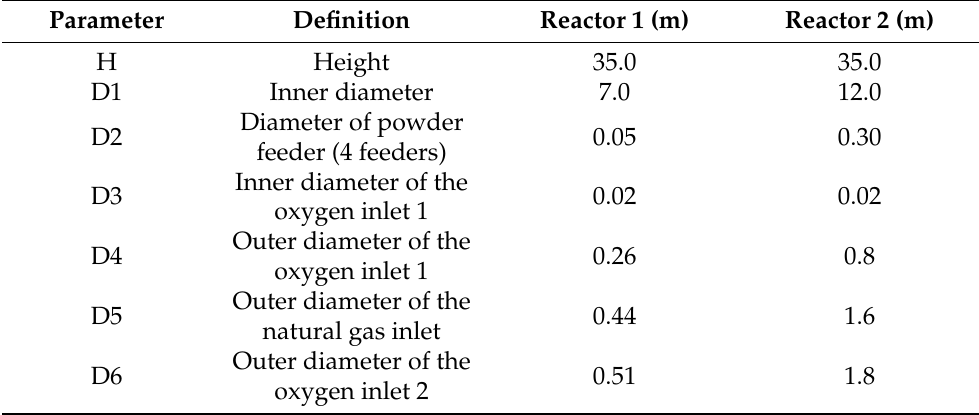
Table 10. The dimensions of the industrial reactors.